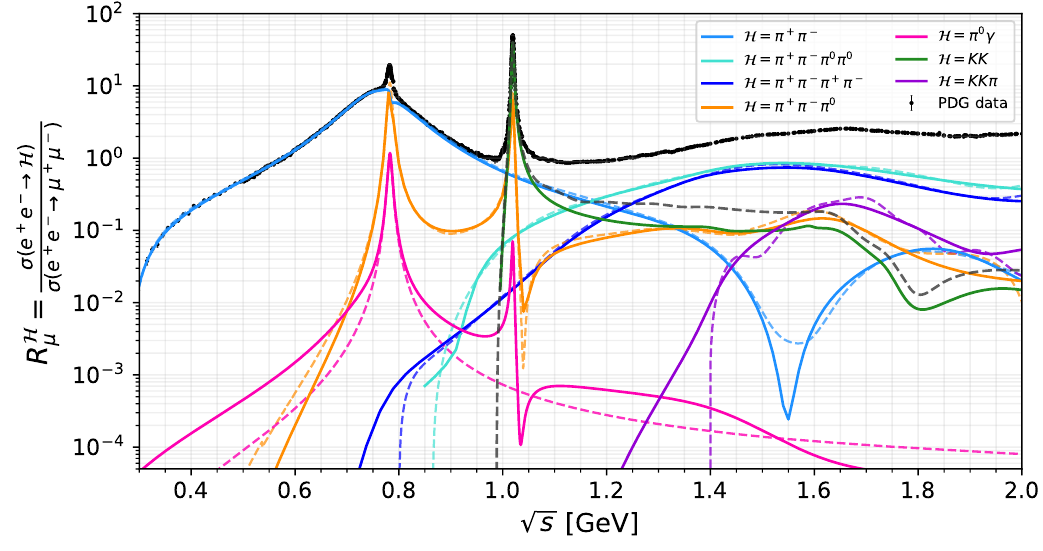
Figure 1 . Cross-sections for the dominant e + e − → H channels, normalized by the e + e − → µ + µ − cross-section. The solid (dashed) lines indicate results obtained in this work (taken from DarkCast [13]). The data (black points) was taken from the Particle Data Group compilation (PDG) [34]. See text for discussions on the